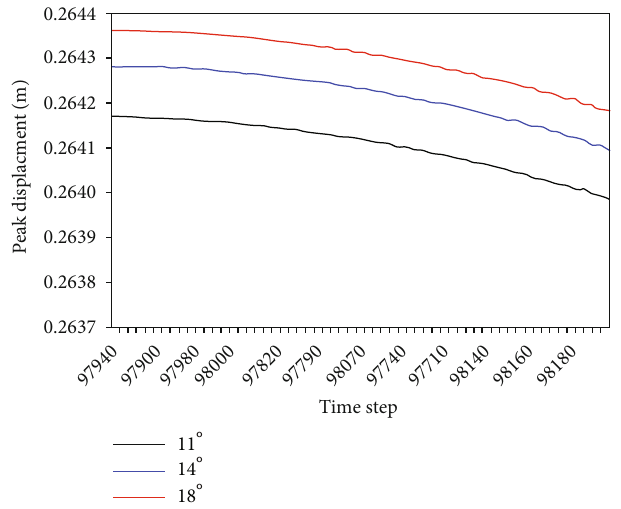
Figure 10: Distribution of the maximum displacement peak against the calculation time step.